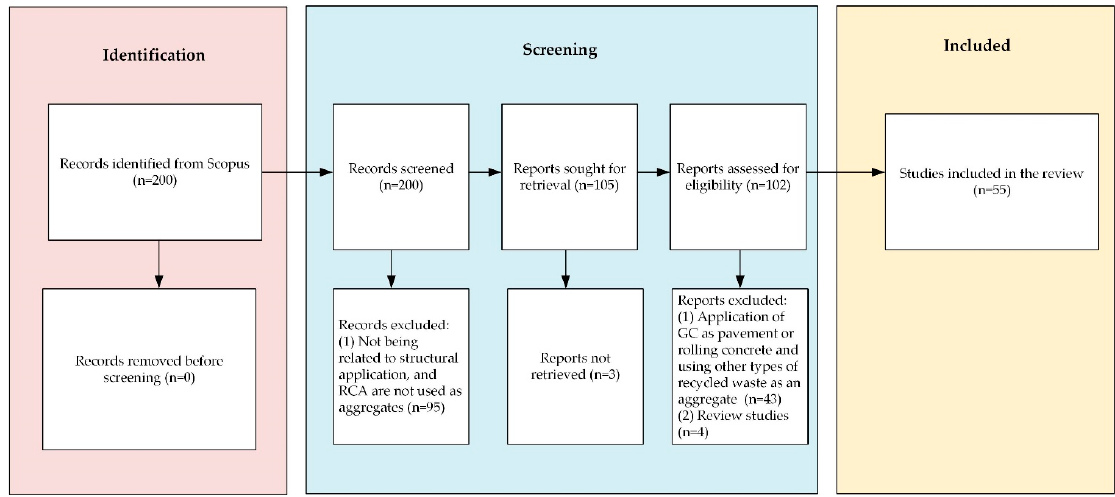
Figure 2. PRISMA flowchart of the data screening process (adapted from Page, et al. [57]).